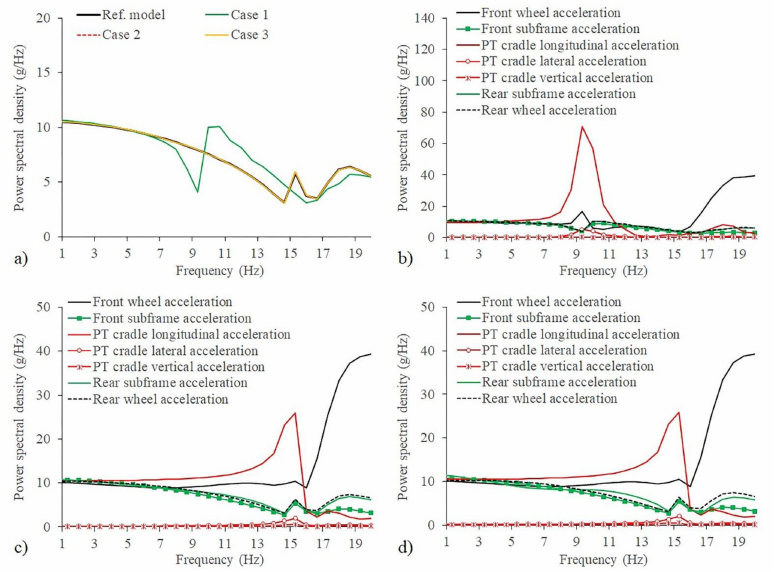
Figure 13. Tip-in event low-frequency resonances on the tarmac: ( a ) vehicle body; ( b ) case 1; ( c ) case 2; ( d ) case